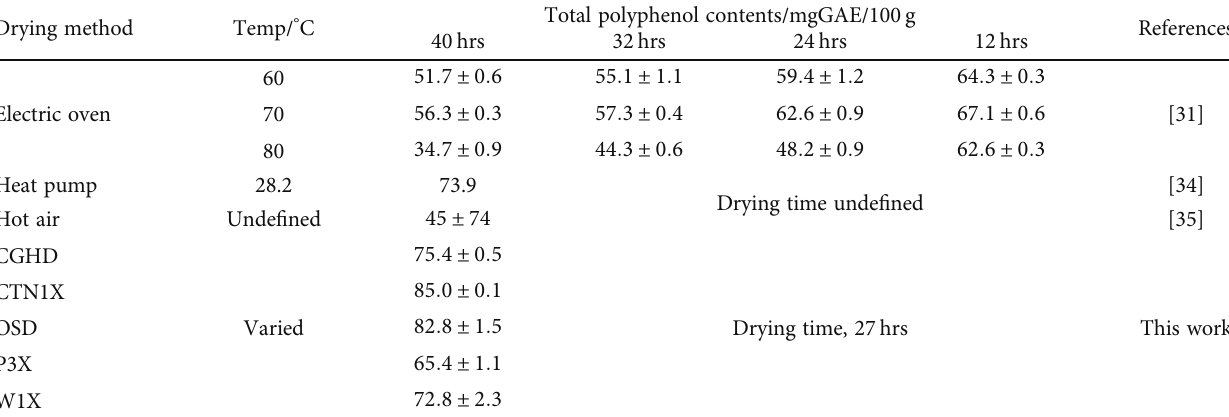
Table 2: Polyphenol content of cocoa beans dried in some active dryers.